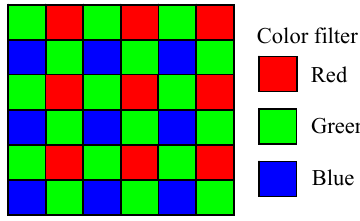
Fig. 1. Sample of Bayer Color Filter Array.